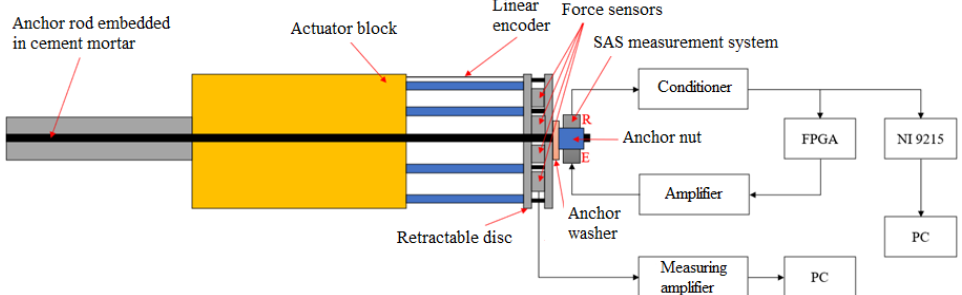
Figure 5. Block diagram of the laboratory: R—receiver; E—exciter.